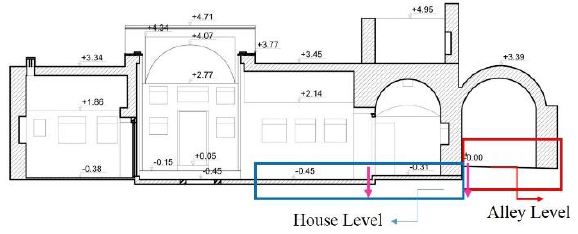
Figure 12. The lower house level than the alley